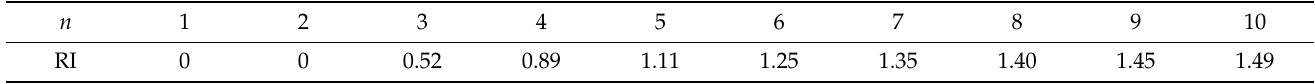
Table 3. Random Index (RI) of the calculated AHP matrices.